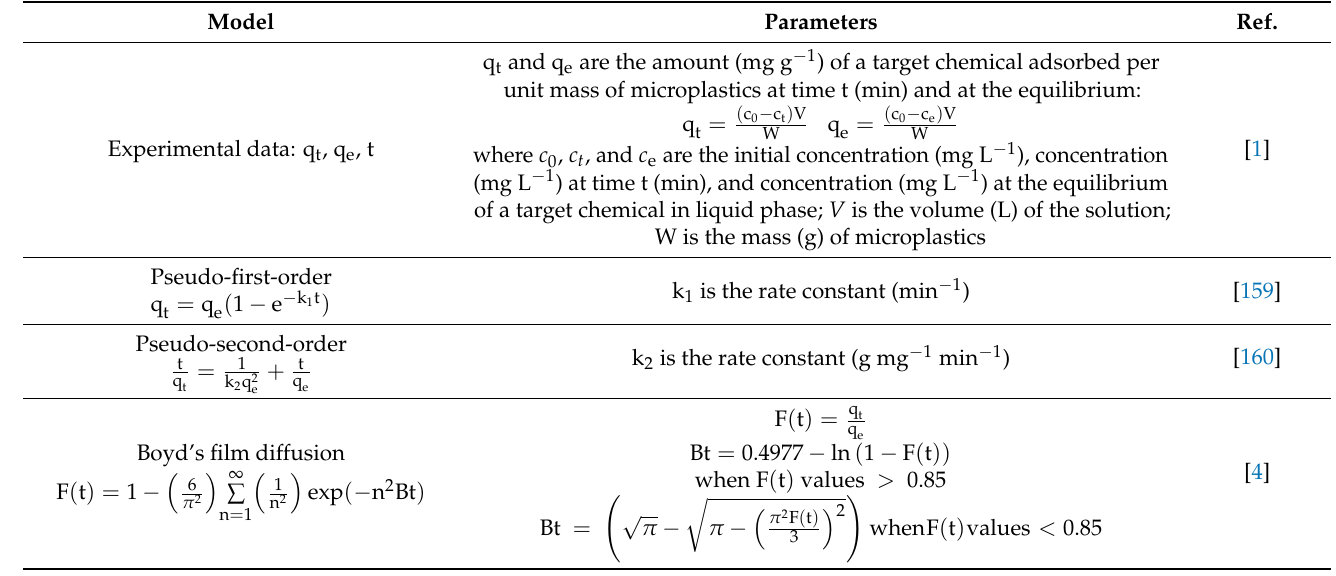
Table 1. Adsorption kinetic